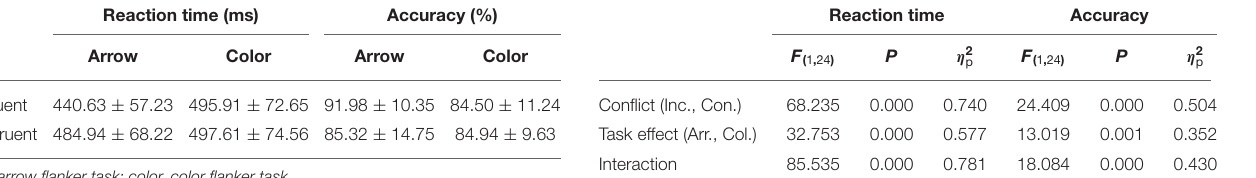
TABLE 1 | Behavioral performance summary (mean ± SD) ( N = 25). Reaction time (ms)